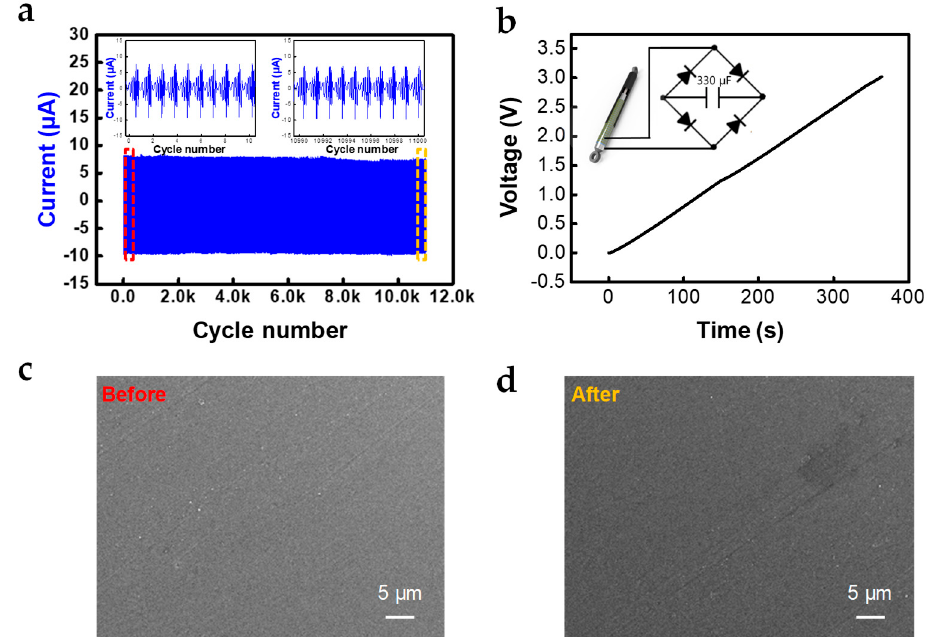
Figure 5. Stability of output performance and charging performance: ( a ) durability test for 11,000 cycles with damping force of 0.6 kgf, speed of 140 mm/s and displacement of 50 mm (inset: short-circuit current signals at the beginning and the end of durability test, respectively; red box is the beginning part and orange box is the end part); ( b ) charging curve for 330 µF using a rectifying bridge, with a frictional force of 0.6 kgf and speed of 200 mm/s; ( c , d ) SEM images of surface morphology of PFA film before and after the durability test, respectively.